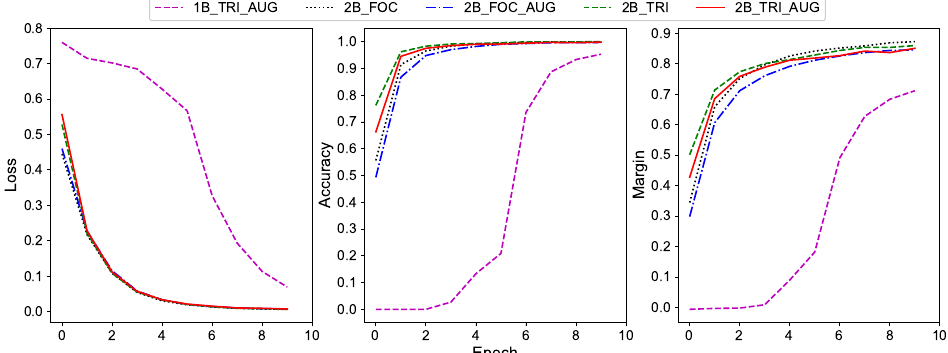
Figure 9. Loss, accuracy, and margin w.r.t. epoch number in training for different network structures and augmentation methods.